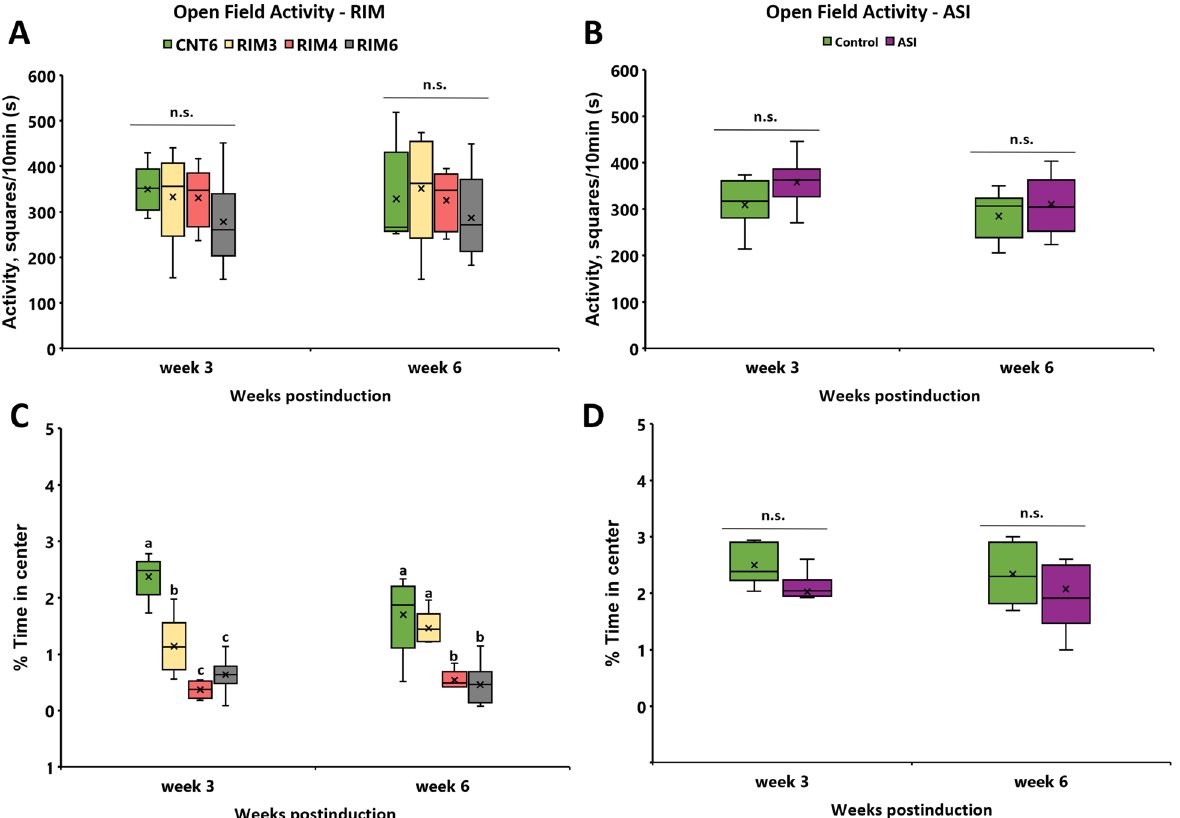
Figure 4. Open field behavioral assessment at 3 and 6 weeks postinduction in mice subjected to reserpine- induced myalgia and intramuscular acid saline solution injection. No locomotor disturbances were found in the ( A ) RIM or ( B ) ASI models. ( C ) RIM3, RIM4 and RIM6 showed significantly decreased time spent in the center when compared with CNT6 at 3 weeks postinduction. At 6 weeks, RIM4 and RIM6 still showed this significant decrease, whereas RIM3 showed no differences in comparison to CNT6. Additionally, the difference between the time spent in zones was significantly increased in the RIM6 group. ( D ) A lack of significance was observed in ASI mice. Data are expressed as the median ± IQR, and the mean is also shown as x. a–c: Groups not sharing a letter showed significant differences in time spent in the OF center, p <